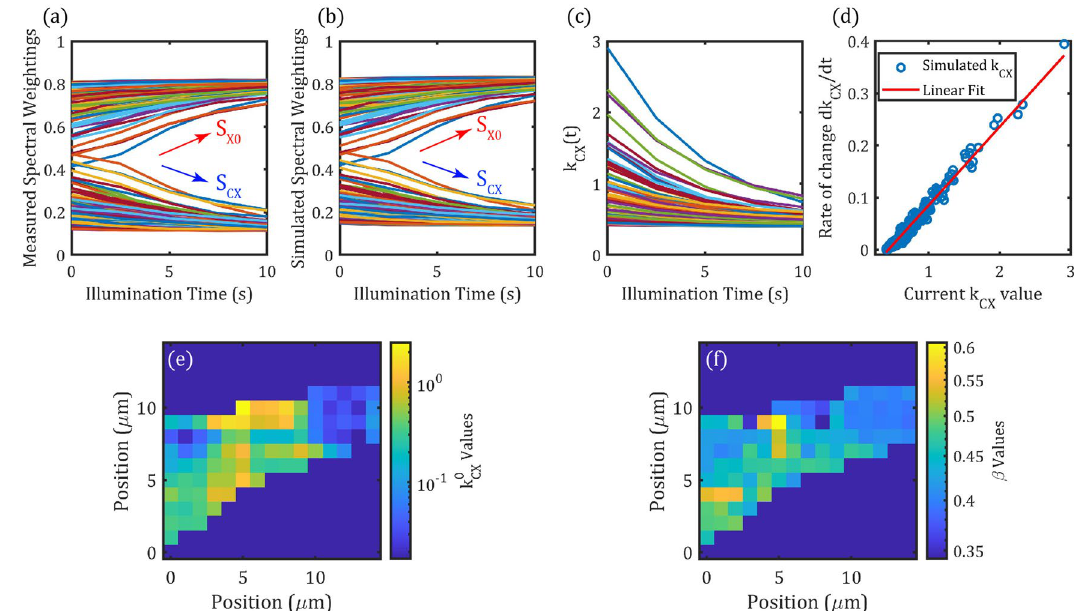
Figure 4. Spatial–temporal analysis of spectral weighting changes. ( a ) Spectral weighting obtained from Voigt fitting for all pixels, plotted against the corresponding illumination time. ( b ) Spectral weighting obtained from the steady state model after optimisation step to obtain k CX ( x , y , t ) . ( c ) k CX plotted as a function of illumination time, for all spatial locations. ( d ) The rate of change of k CX (t) plotted against its instantaneous value at all time steps and all spatial locations. Linear fit shows that k CX ( t ) can be described by exponential decay,